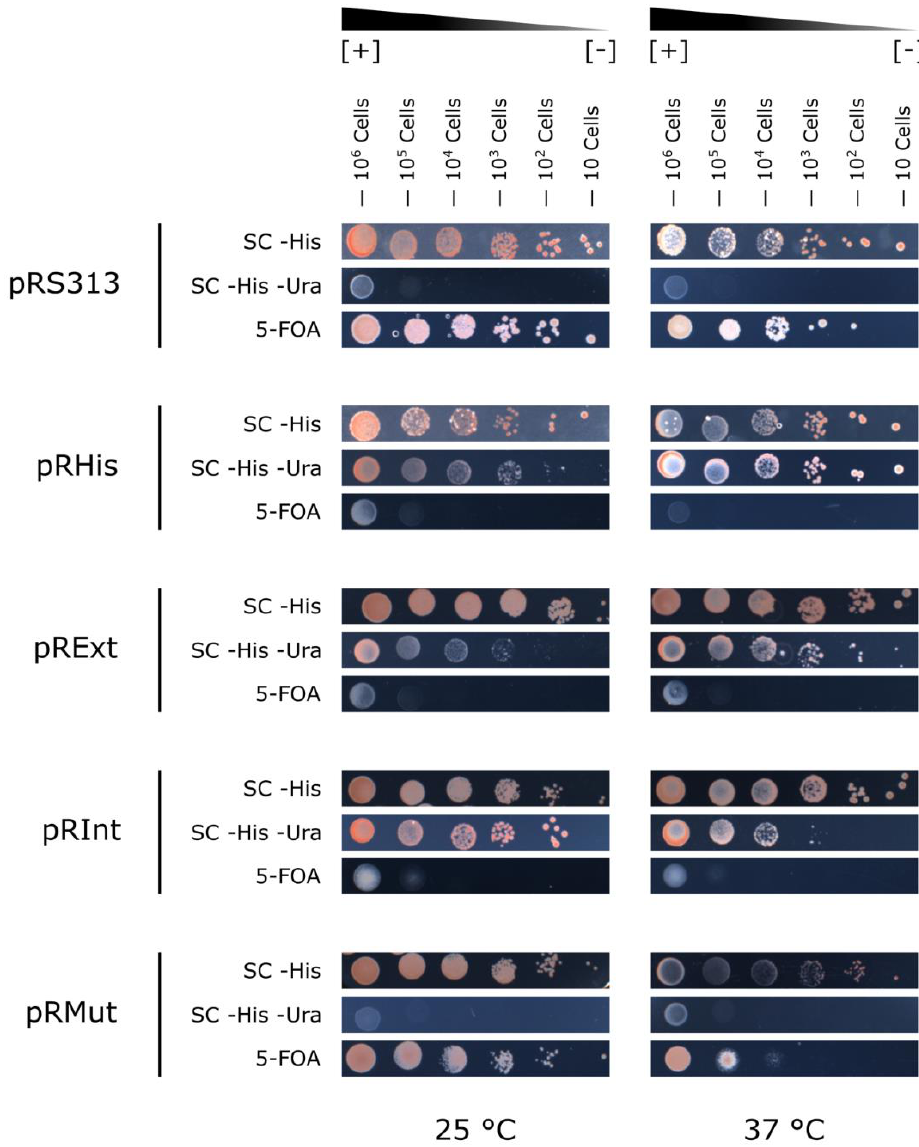
Figure 3. CnePrp8i splicing assessed by growth pattern of pRS313, pRHis, pRExt, pRInt and pRMut transformed yeast cells. Using the yeast spot plating assay, 10 6 to 10 yeast cells were cultured on SC -His, SC -His -Ura and 5-FOA media at 25 ◦ C and 37 ◦ C and the growth pattern was according to the expected in Figure 2B.